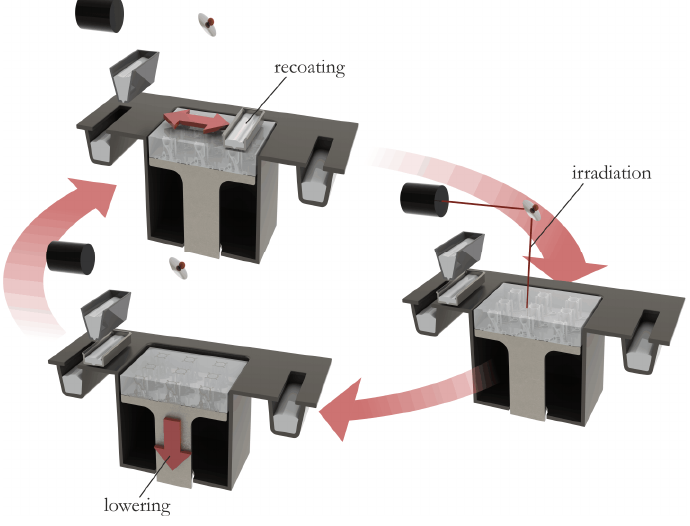
Figure 1: Basic steps of